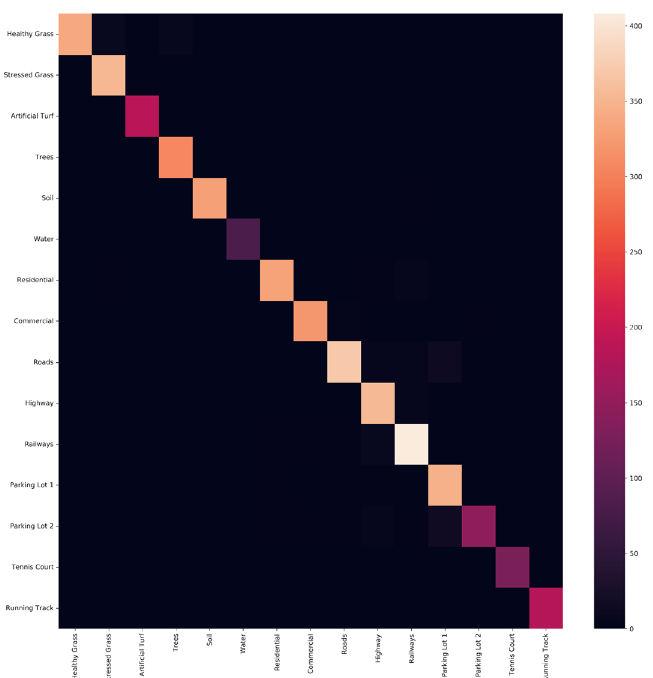
Fig. 14 Houston Confusion Matrix for PCA 30 CEU-Net no patching with a 75%/25% Training/Testing